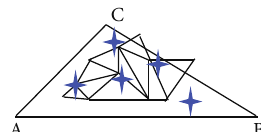
Figure 2: Structural unit with Gauss integral points.